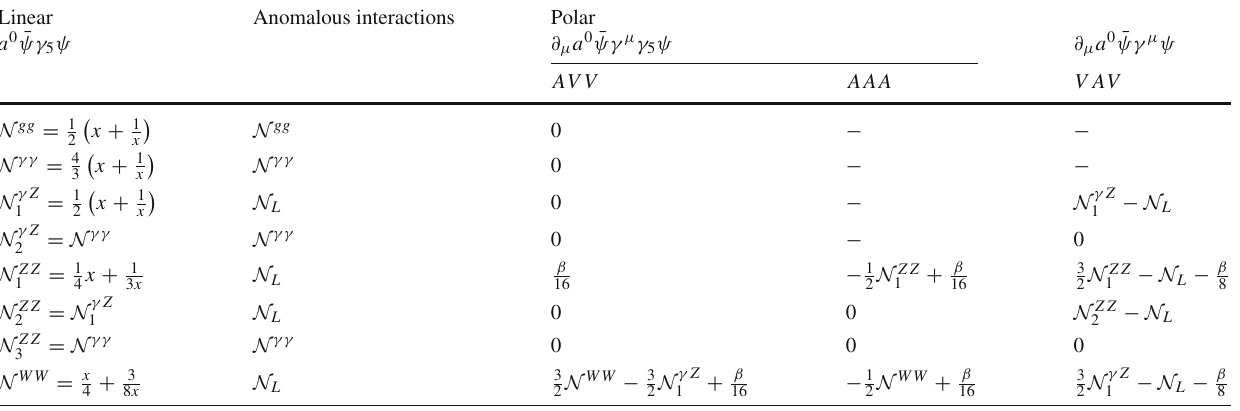
coefficient N L = − 1 / 2 ( 3 α + β) , with α and β being the free parame- ters tuning the U ( 1 ) B and U ( 1 ) L components of U ( 1 ) PQ . The explicit presence of β in the a 0 → Z Z , WW triangles is due to the peculiar nature of the neutrinos, which are kept massless. They do not contribute in the linear representation but have to explicitly appear in the anoma- lous interactions and derivative terms since those are SU ( 2 ) L ⊗ U ( 1 ) Y invariant